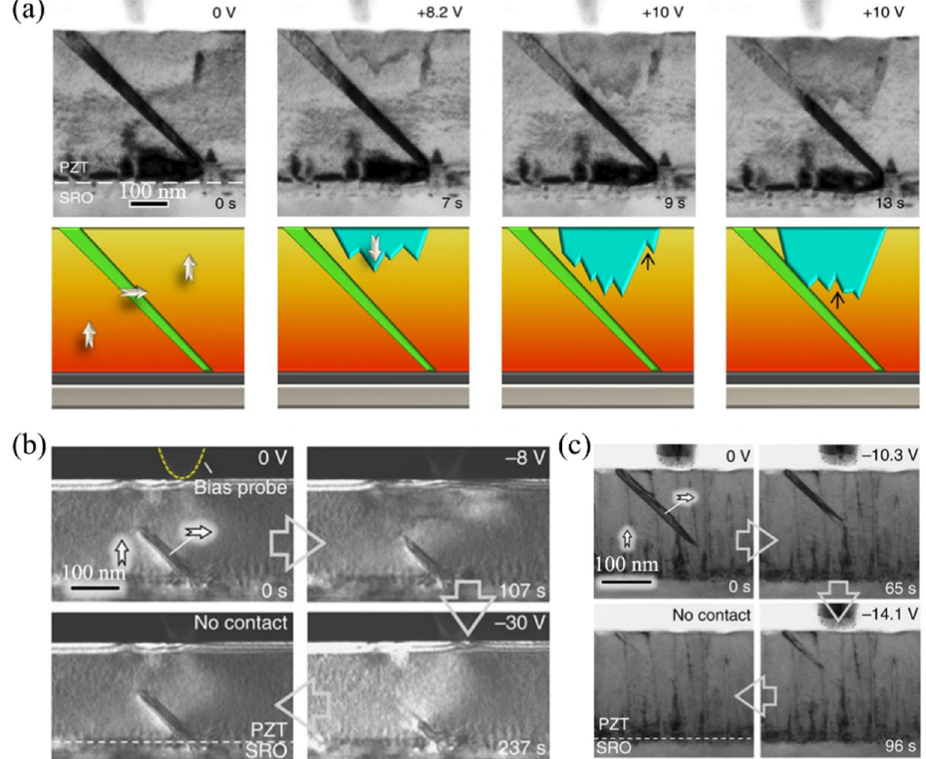
Figure 12. Domains evolution under the external electric field along the out-of-plane direction. ( a ) The TEM images (up) and the schematic diagrams (down) show the formation and propagation of c-domain. Reprinted with permission from [146] 2013 Springer Nature. ( b , c ) The TEM images of a-domain evolution. Reprinted with permission from [147] 2014 Springer Nature: ( b ) reversible evolution at the film/substrate interface; ( c ) irreversible evolution at the free surface.